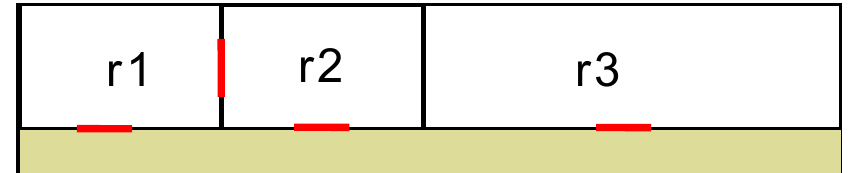
Figure 6. A simplified floor plan with three rooms.